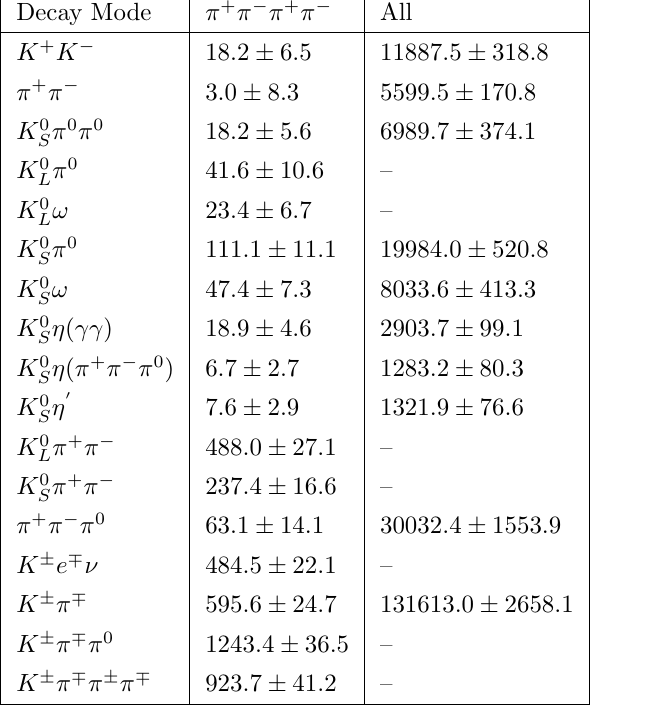
Table 2 . Number of selected single- and double-tagged decays after background subtraction.